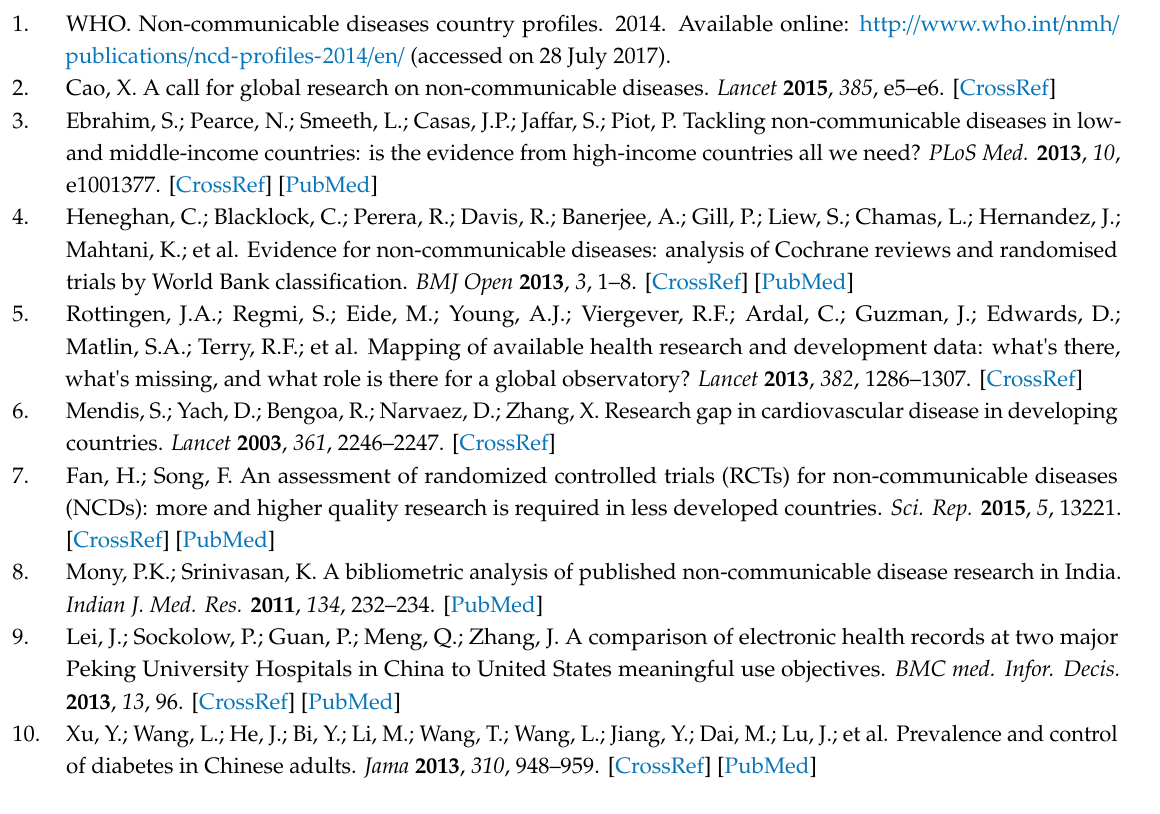
Figure S1: title, Table S1: title, Video S1: